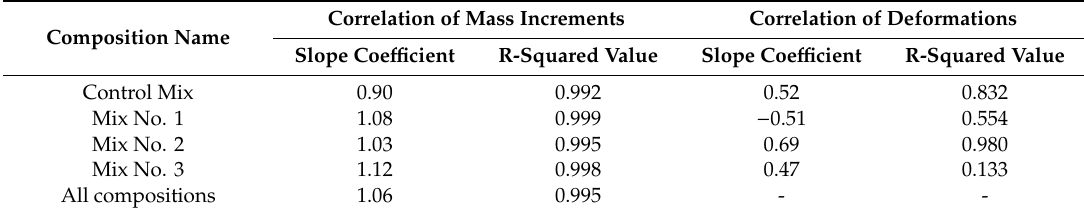
Figure 5. Mass increment of samples in Na 2 SO 4 solution as a function of the mass increment in water at the same times. Table 5. Approximation